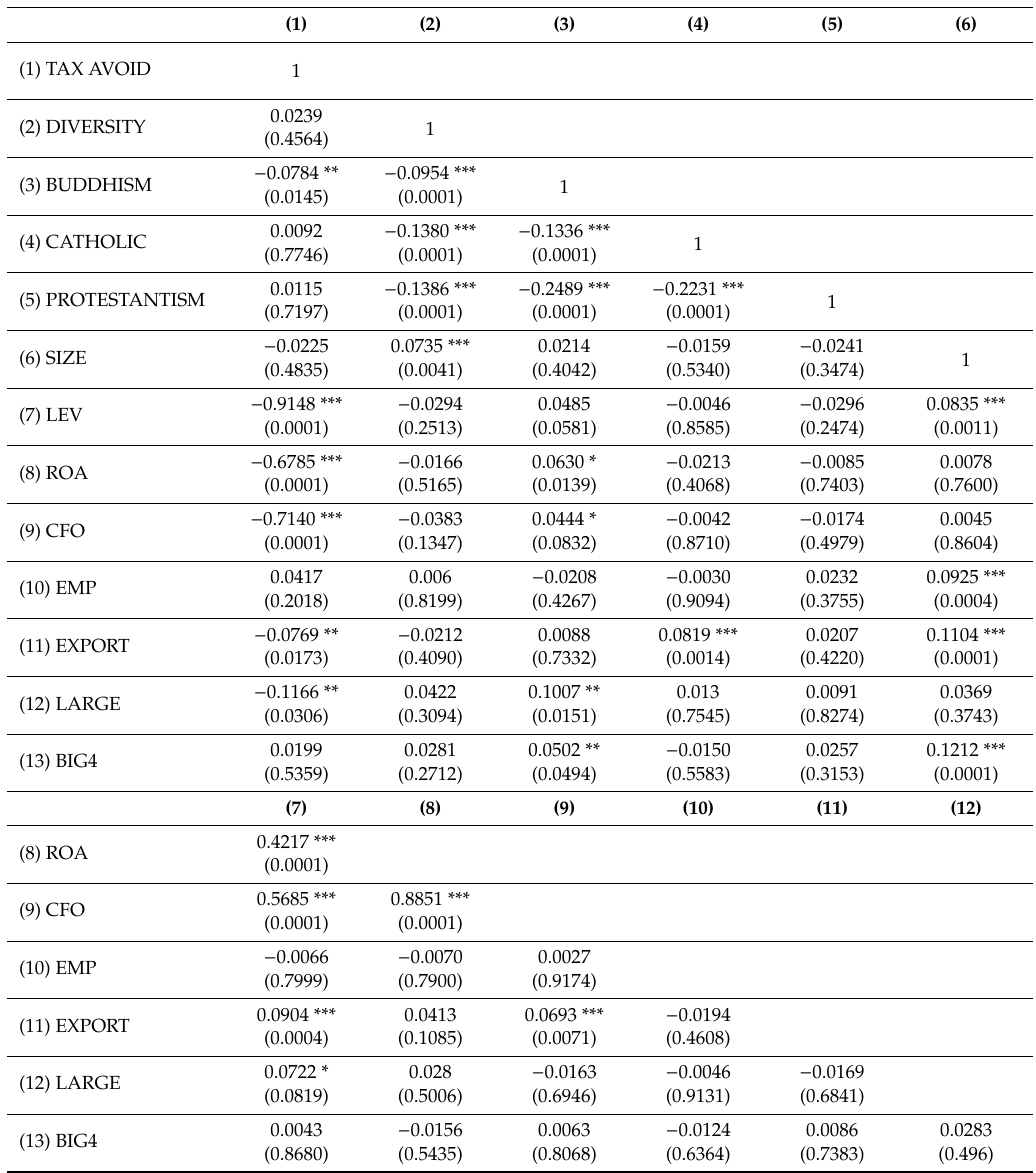
Table 2. Correlation